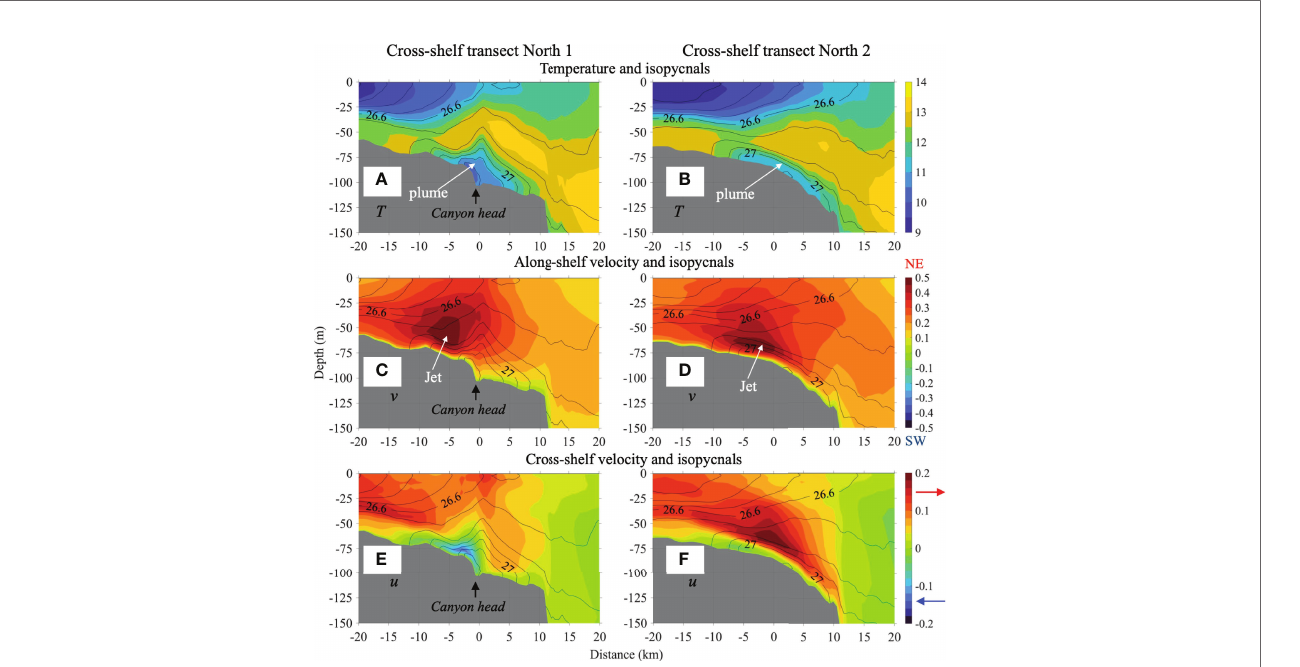
FIGURE 11 | Cross-shelf transect views of daily mean (A, B) temperature, (C, D) along-shelf velocity, and (E, F) cross-shelf velocity on March 1 during the upwelling event, contours are isopycnals. The locations of transects A and B are shown in Figure 10 (Mar 1). The positive direction of along-shelf velocity is pointing northeastward, of cross-shelf velocity is pointing seaward. The cold and dense canyon-upwelled dense water over fl ow was seen at the canyon head. A subsurface along-shelf frontal jet was located at the shoreward fl ank of the canyon-upwelled over fl ow water. The frontal jet fl owed towards northeast. At transect A, the dense water also expanded both shoreward and seaward in the cross-shelf